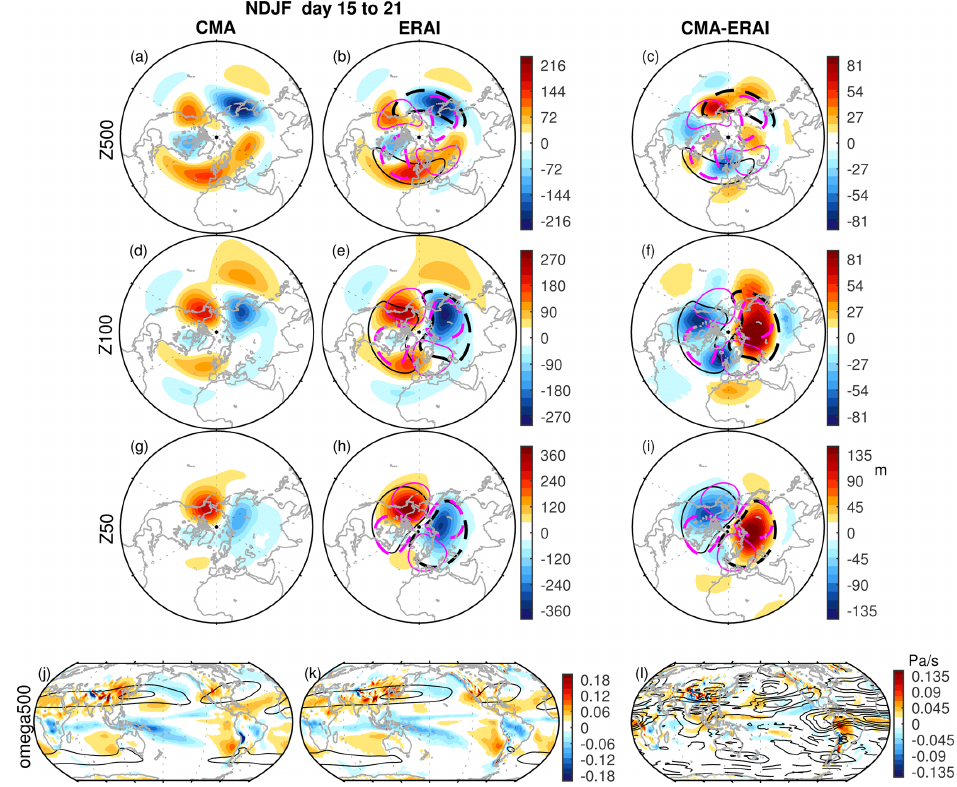
Figure 5. Same as Fig. 4 but for the CMA